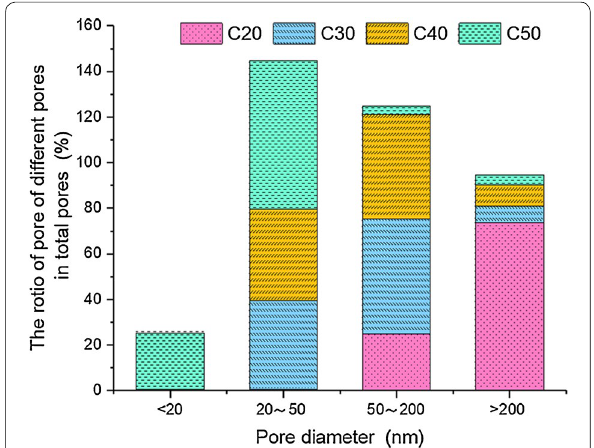
Fig. 14 Same pore diameter distribution of different concrete strengths. Fig. 15 Pore diameter distribution of different concrete